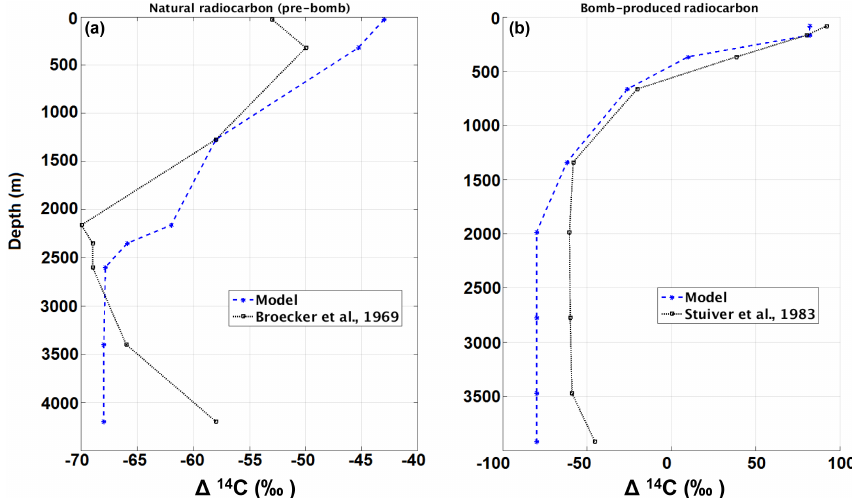
Figure 4. Model–data comparison of (cid:49) 14 C vertical profiles for (a) the pre-bomb distribution as a composite of seawater observations from different locations measured by (Broecker and Gerard, 1969) and (b) total radiocarbon distributions (natural + bomb) in the eastern basin measured by (Stuiver et al., 1983) at 18 ◦ E. Model results are in blue, while black indicates the in situ data.